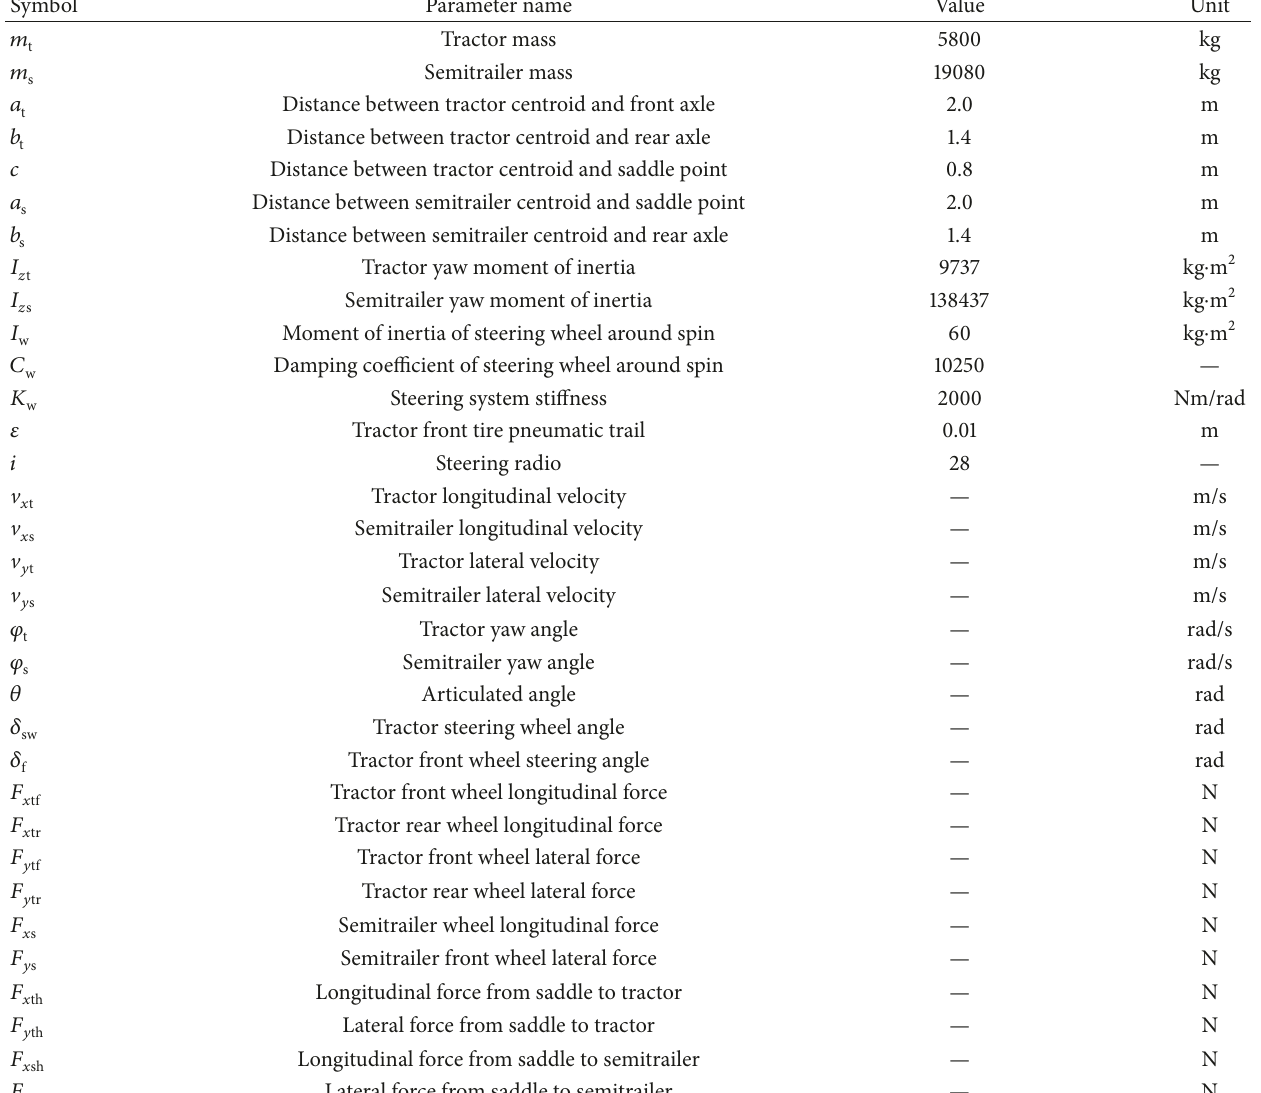
Table 1: Tractor-semitrailer parameters and symbols.